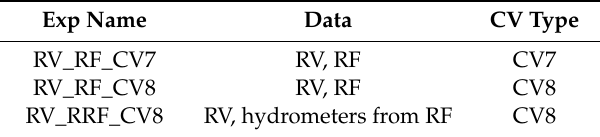
Table 1. Description of the experiments, with radar velocity and radar reflectivity using CV7 (RV_RF_CV7), with radar velocity and radar reflectivity using CV8 (RV_RF_CV8), and with radar velocity and retrieved hydrometers with radar reflectivity using CV8 (RV_RRF_CV8).